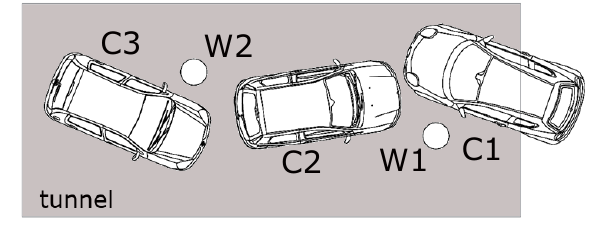
Figure 1. Simulated accident